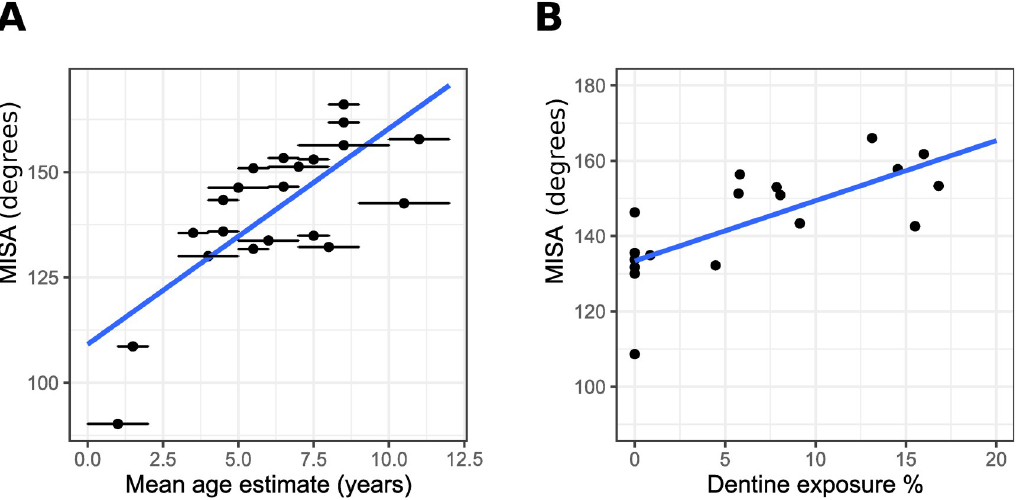
Fig 4. Occlusal topography (MISA) also indicates both age dependent and independent intra-population dental wear variation. (A) Scatterplot of MISA in degrees by mean estimated age with age estimation uncertainty error bars. (B) Scatter plot of MISA in degrees by dentine exposure